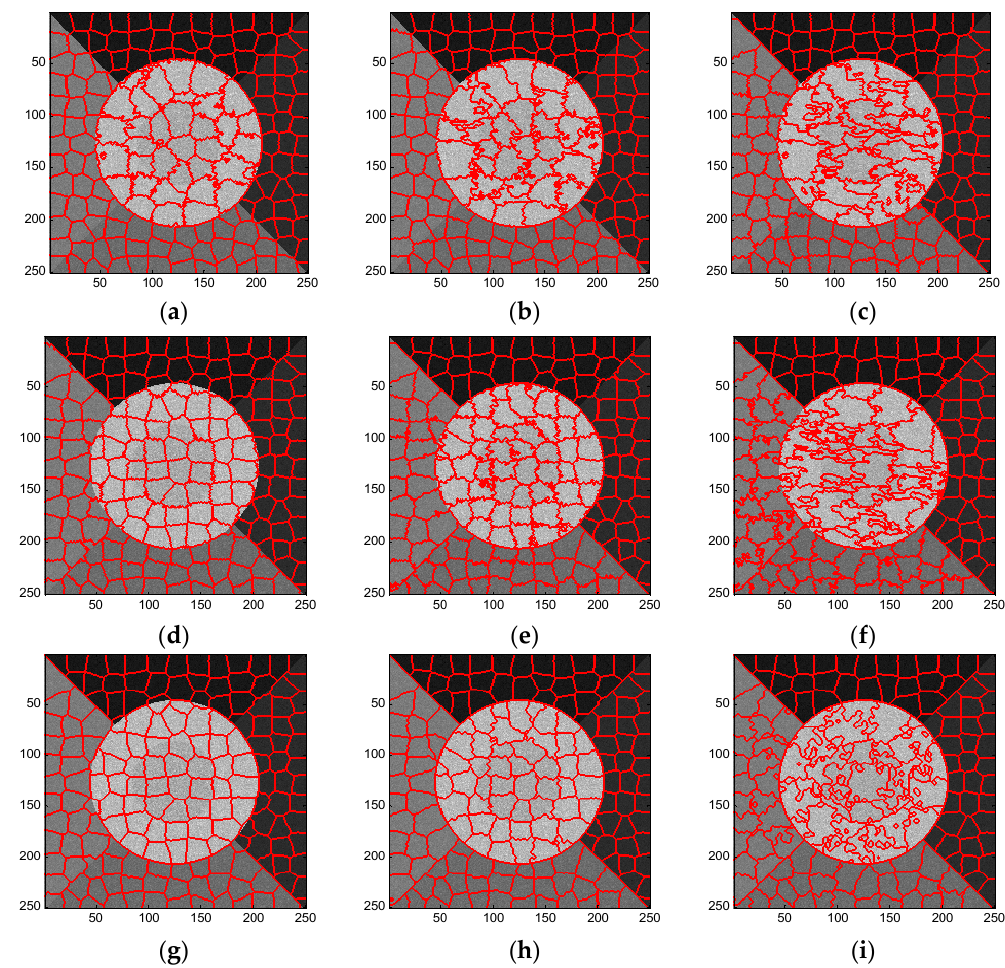
Figure 5. Superpixels of simulated SAR image provided by ( a – c ) standard SLIC algorithm; ( d – f ) compound method; and ( g – i ) proposed algorithm with regularization parameter w set to 0.3, 0.6 and 0.9, from left to right.